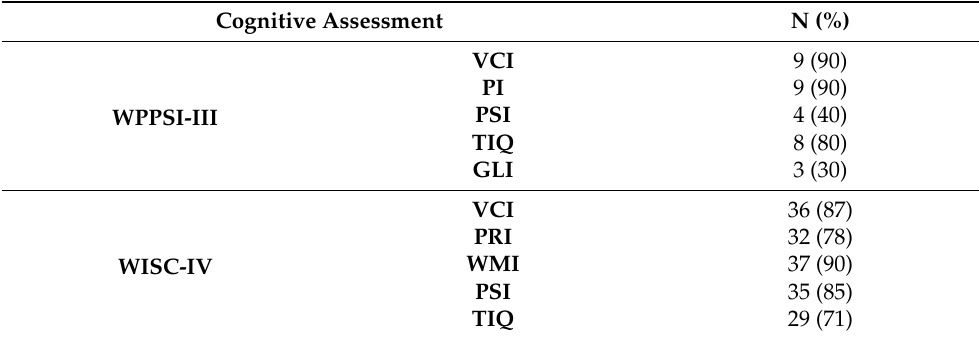
Table 3. Cognitive assessment. N indicates the number of subjects who performed the test or had an interpretable result, with the percentage of subjects that completed the test according to age (see Materials and Methods section for abbreviations).